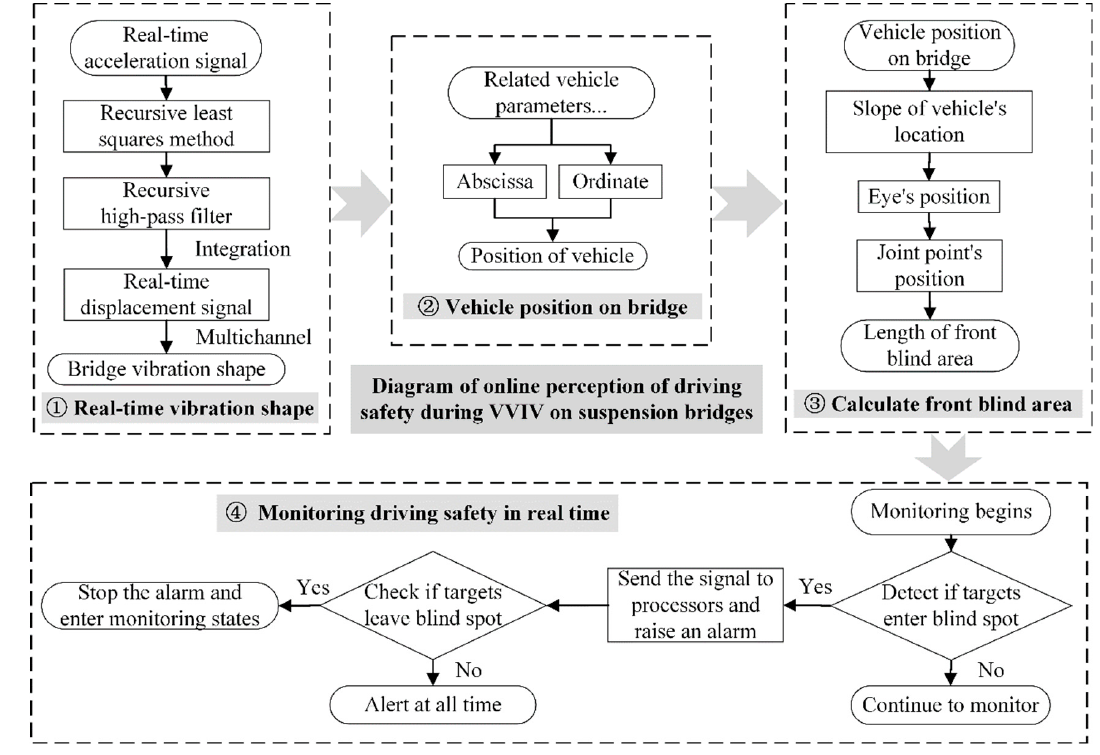
Figure 12. Diagram of online perception of driving safety on suspension bridge experiencing VVIV.